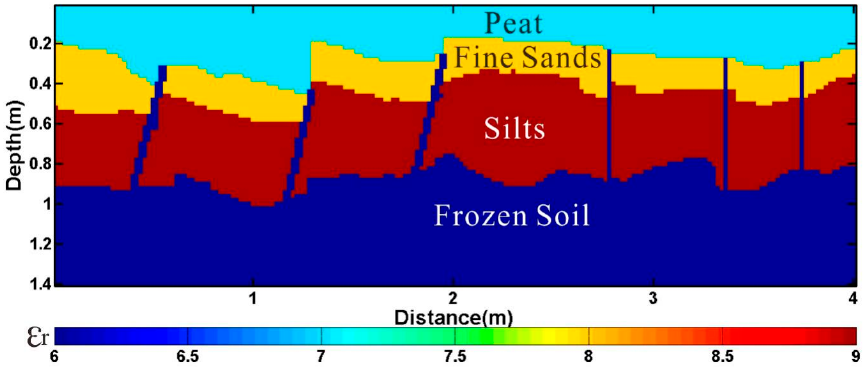
Figure 9. The relative dielectric constant model was designed using the L3 line RTM profile.